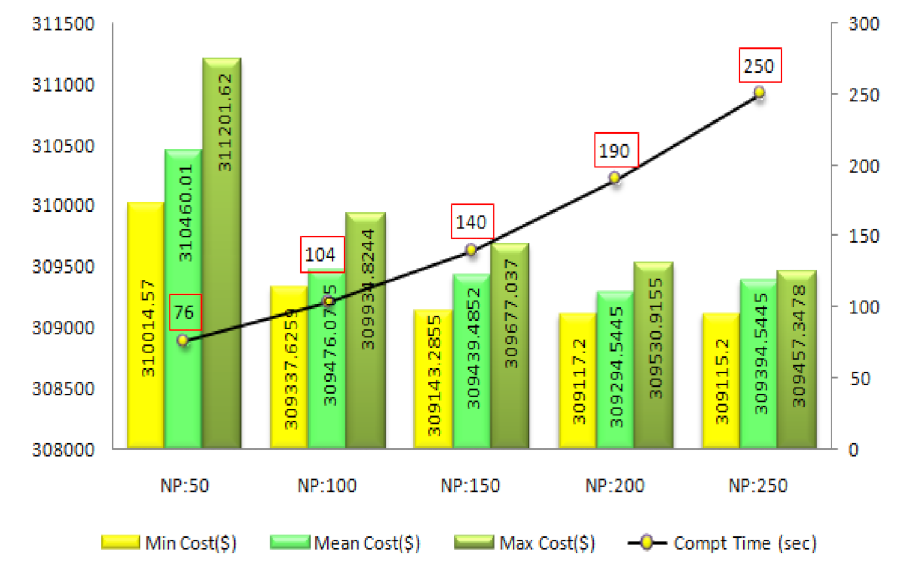
Figure 6. Effect of Number of particles (NP). Table 1. Comparison of EO with ABC and PSO for Test Case 1.